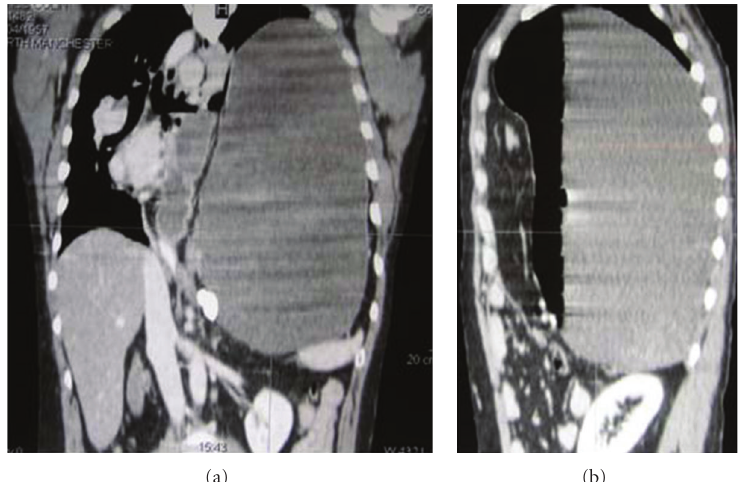
Figure 15: Coronal and sagittal CT reconstruction on the same patient as Figures 13, 14, and 15 showing diaphragmatic rupture and herniation of the stomach into the left hemithorax.